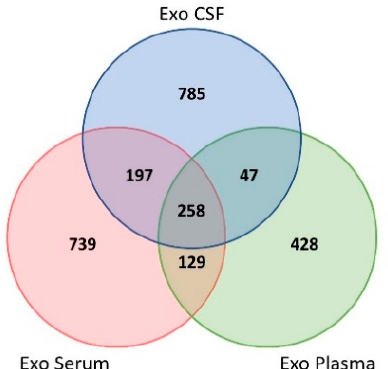
Figure 3. Overlap of the distinct biofluids exosomal proteomes. Venn diagram overlapping serum, plasma and CSF-derived exosomal proteomes. Abbreviations: Exo, exosomes; CSF, cerebrospinal fluid.